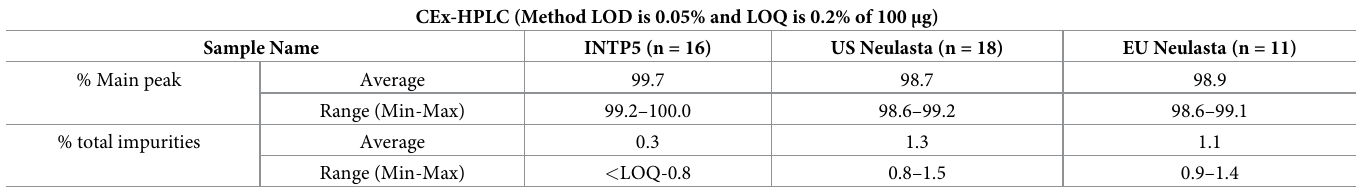
Table 2. Quantitative purity analysis of INTP5, US Neulasta and EU Neulasta by